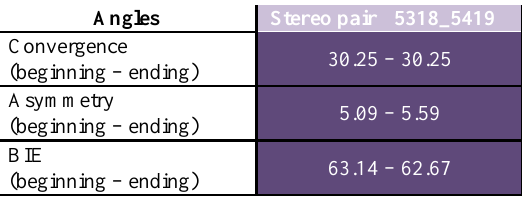
Table 2: Angles defining the stereo